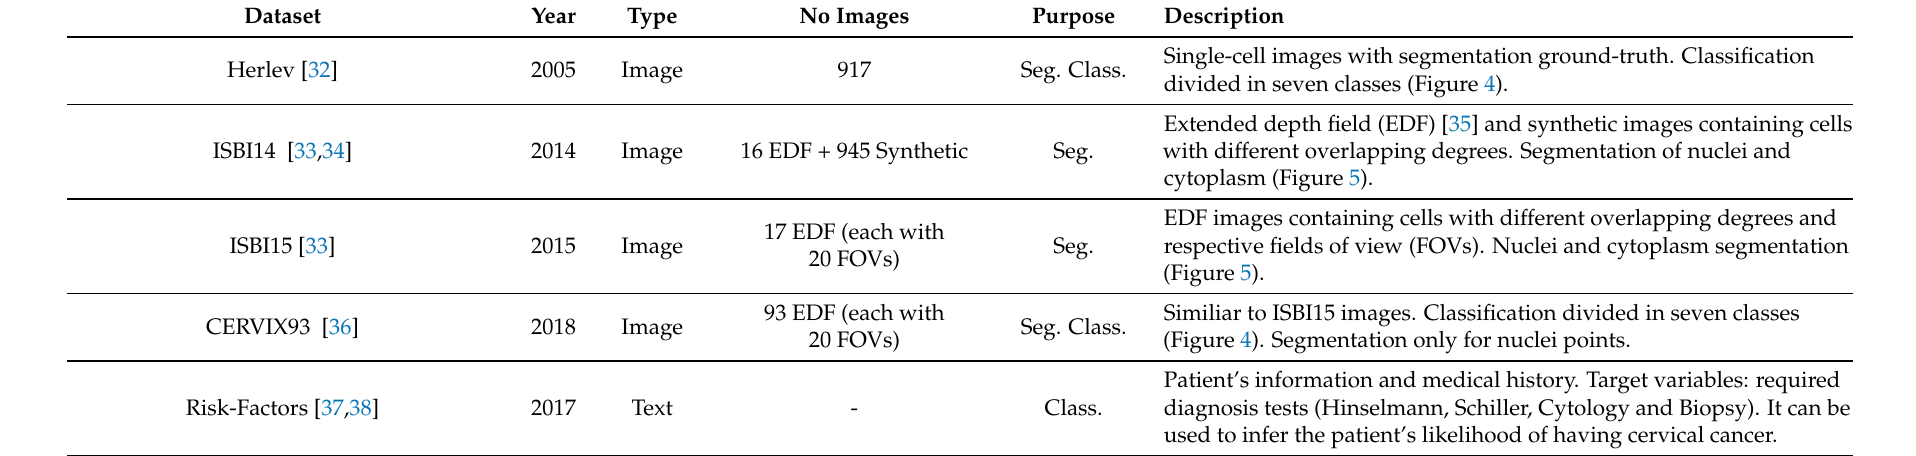
Table 2. Public datasets summary. Seg. (Segmentation); Class.